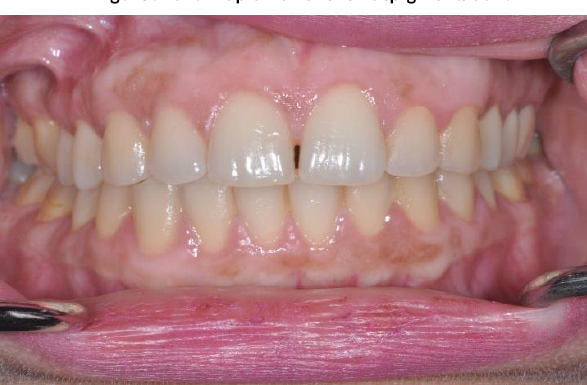
Fig. 13. Follow-up of lower arch depigmentation.